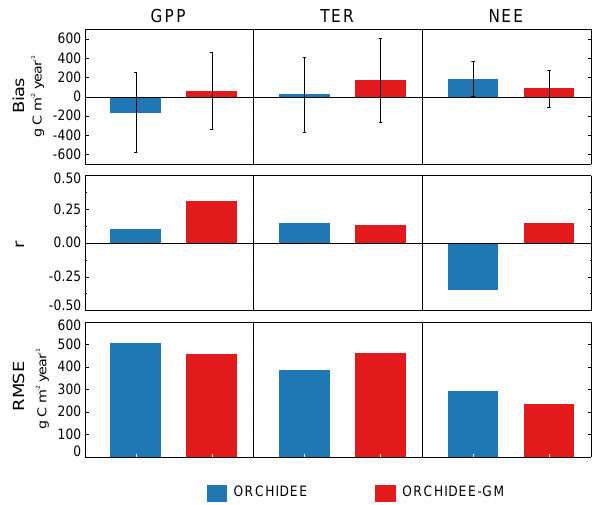
Fig. 8. Statistical performance of models on an interannual scale for CO 2 fluxes (GPP, TER and NEE). Bias: mean model bias (modeled–observed, gCm − 2 yr − 1 ) over all site-years, error bar presents the standard deviation of biases; r : correlation between observed and modeled interannual variability; RMSE: root mean squared error for interannual variability in annual totals of CO 2